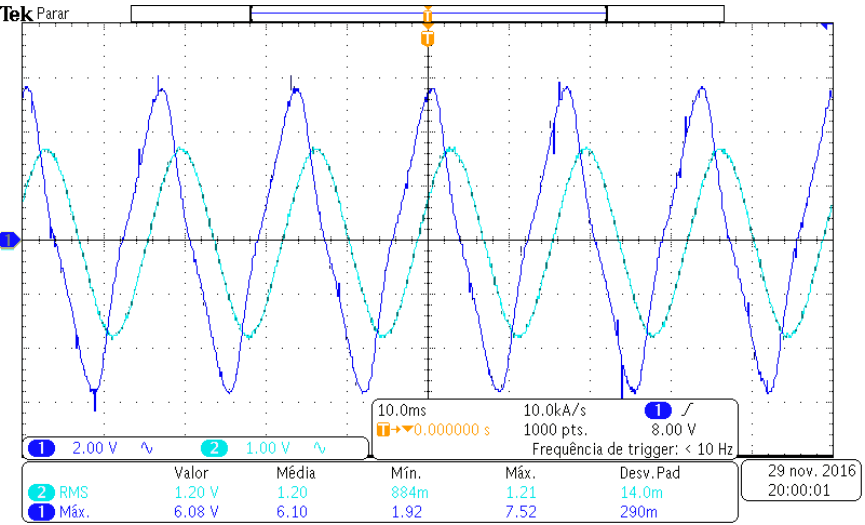
Figure 11. Waveform showing the voltage generated in the generator device.